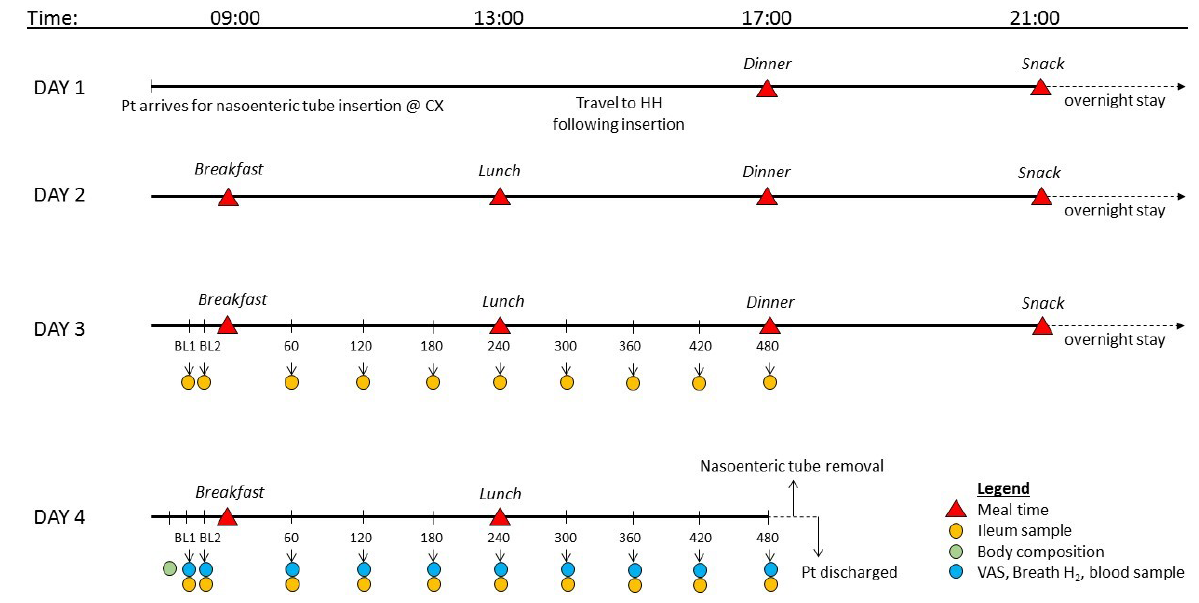
Figure 1. Study visit overview. Abbreviations: BL, baseline; CX, Charing Cross Hospital; HH, Hammersmith Hospital; Pt, patient; VAS, visual analogue